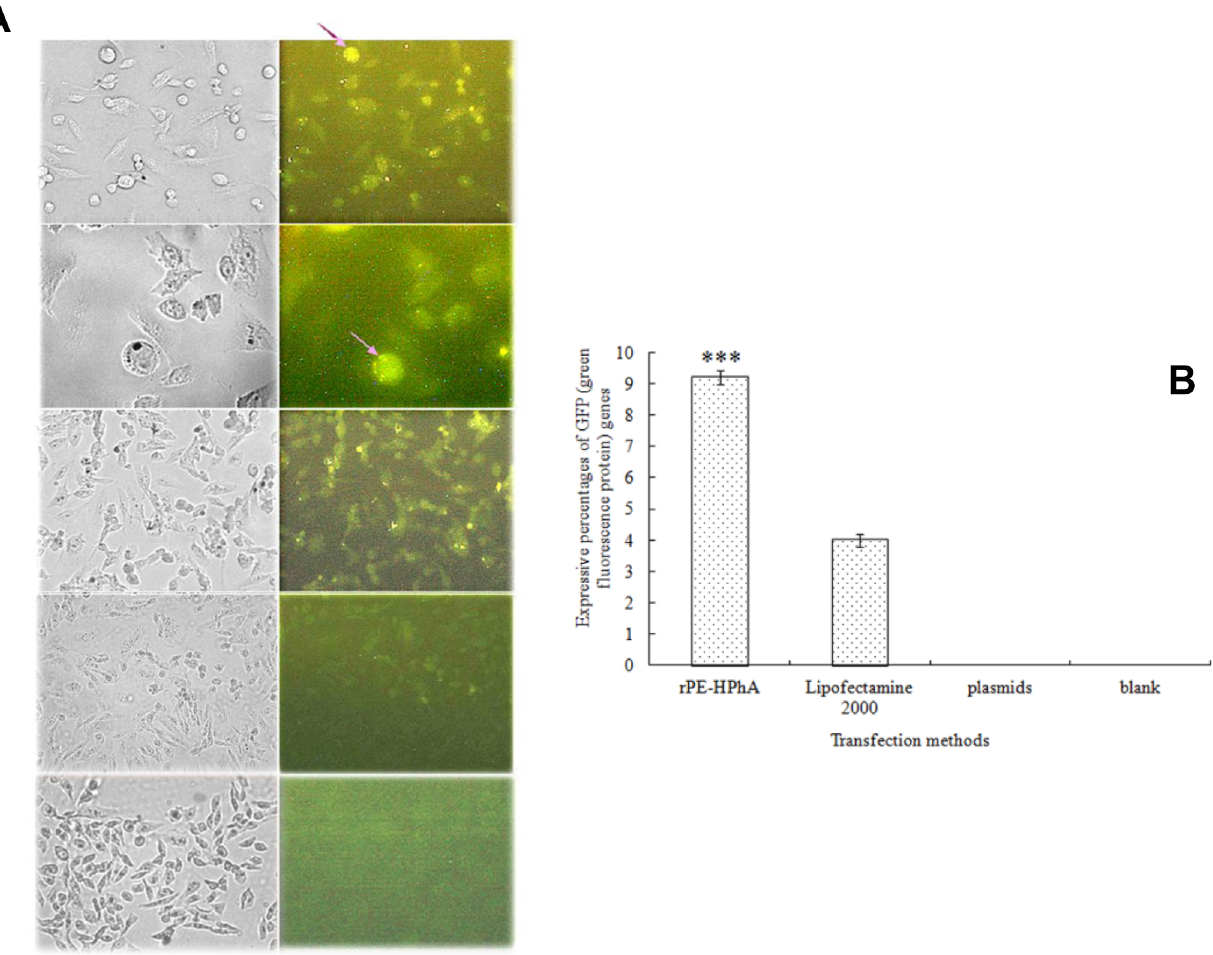
Fig 4. The transfection ability of the DNA delivery protein rPE-HPhA in CHO cells. A) The first and second panels: CHO cells were treated with a mixture of plasmid pEGFP-C1 (2ug) and rPE-HPhA (4ug). EGFP expression was detected with fluorescent microscope. Arrows indicate the green fluorescence spot in transfected cell; The first panel: visible light 200 × (left) and fluorescence 200 × (right); The second panel: visible light 400 × (left) and fluorescence 400 × (right); The third panel: CHO cells was treated with a mixture of EGFP (2ug) and lipofectamine 2000 (3ul). Visible light 200 × (left) and fluorescence 200 × (right); The fourth panel: CHO cells were treated with plasmid EGFP alone. Visible light 200 × (left) and fluorescence 200 × (right); The fifth panel: Untreated cells, no green fluorescence was detected in the 4 th and 5 th panels. B) Transfer efficiency of rPE-HPhA, Lipofectamine 2000, pEGFP-C1 and/or Untreated cells. Asterisk represents the level of significance between rPE-HPhA groups versus Lipofectamine 2000 groups ( *** p < 0.001). Error bars represent mean ± SEM of three independent